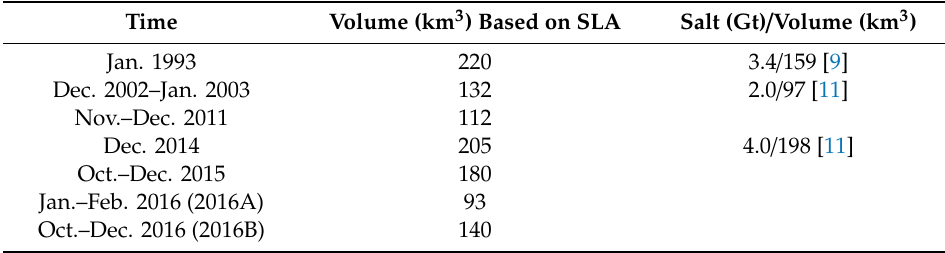
Table 3. Estimates of the volume of water transported into the Baltic Sea during Major Baltic Inflows based on SLA. Column on the right side shows data from the